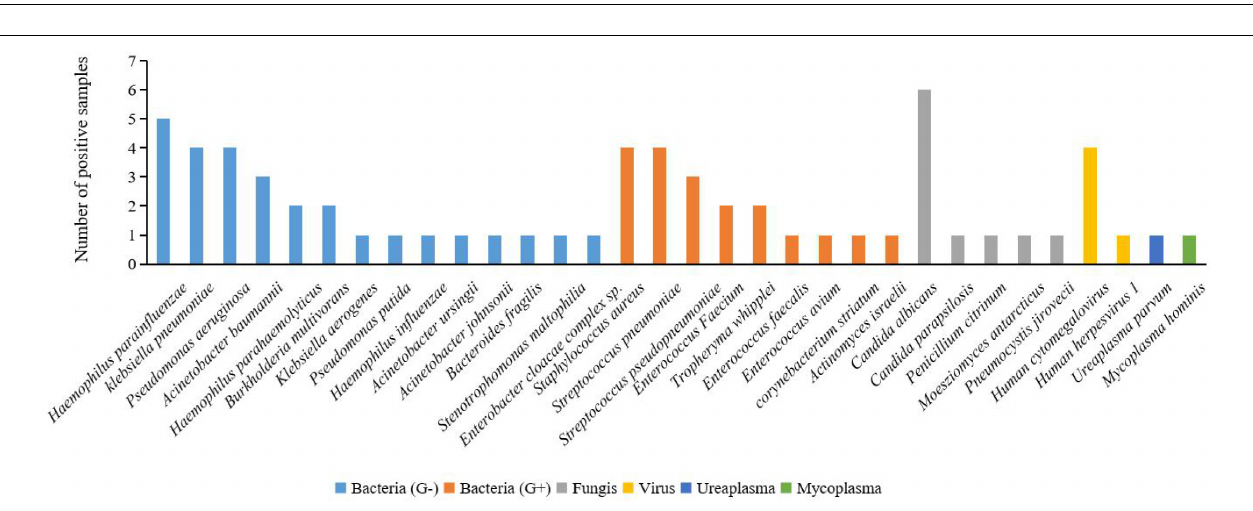
FIGURE 2 | The positive rate of different samples and the proportion of pathogens detected. The positive rate of mNGS detection was significantly higher than in the pathogen culture of the same BALF samples (mNGS vs. culture: 86.67% vs. 30.0%). Some viruses and mycoplasma were detected by mNGS but not by culture method. Among all three kinds of clinical samples, BALF samples showed the highest clinical pathogen diagnostic value: only virus detected in recipient lung tissue; only virus and mycoplasma detected in donor lung tissue, but most kinds of pathogens were detected in BALF and the bacteria made up the majority.